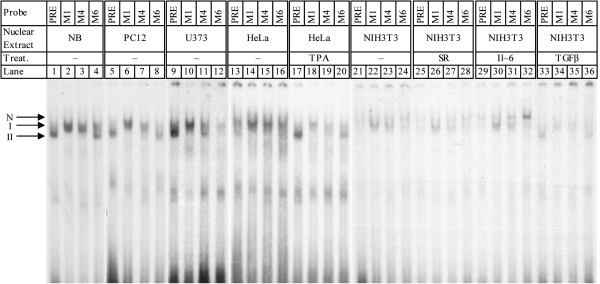
EMSA of PRE and selected mutants in NB, PC12, HeLa, NIH3T3, and U373 nuclear extracts. Wildtype oligomers (lanes 1, 5, 9, 13, 17, 21, 25, 29, 33) and oligomers for the M1 (lanes 2, 6, 10, 14, 18, 22, 26, 30, 34), M4 (lanes 3, 7, 11, 15, 19, 23, 27, 31, 35), and M6 (lanes 4, 8, 12, 16, 20, 24, 28, 32, 36) were labeled with γ−32P-ATP, incubated with NB (lanes 1–4) PC12 (lanes 5–8), U373 (lanes 9–12), HeLa (lanes 13–16), HeLa + TPA (lanes 17–20), NIH3T3 (lanes 21–24), NIH3T3 + serum restriction (lanes 25–28), NIH3T3 + IL6 (lanes 29–32), and NIH3T3 + TGFβ (lanes 33–36) nuclear extracts, and analyzed on nondenaturing PAGE, and gels subject to autoradiography.